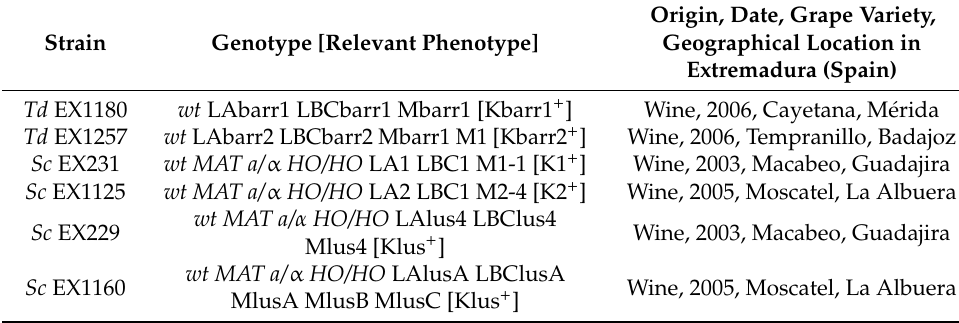
Table 3. Yeasts used in this